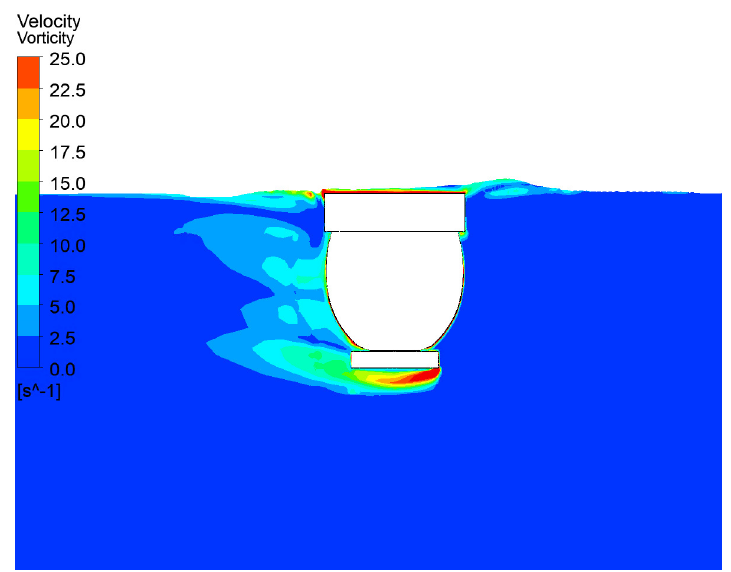
Figure 12. CFD results on the symmetry plane for Re = 7.8 × 10 5 : water vorticity.